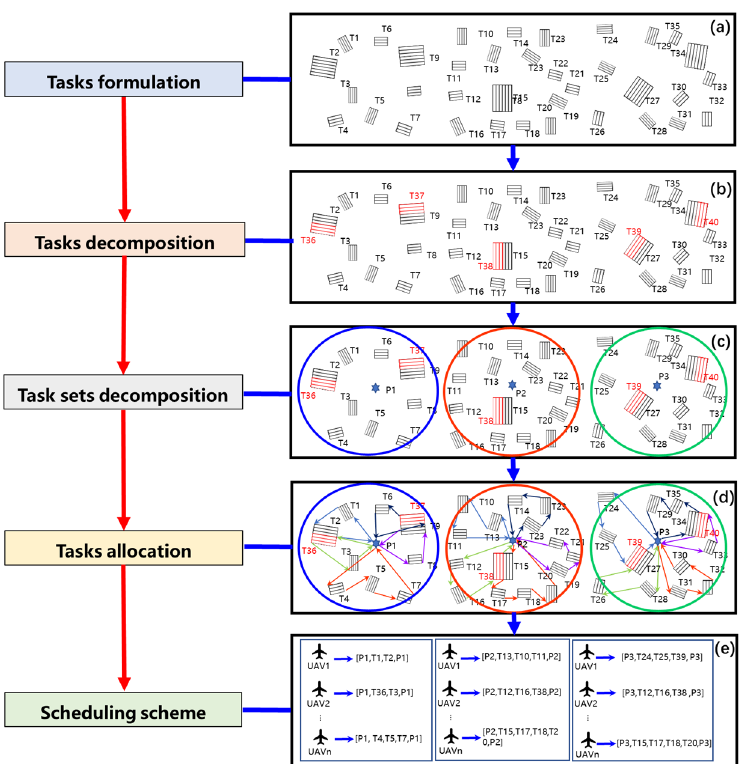
Figure 2. Flow chart of the UAV swarm scheduling method. ( a ) Tasks formulation; ( b ) Tasks decomposition; ( c ) Task sets decomposition; ( d ) Tasks allocation; ( e ) Scheduling scheme.